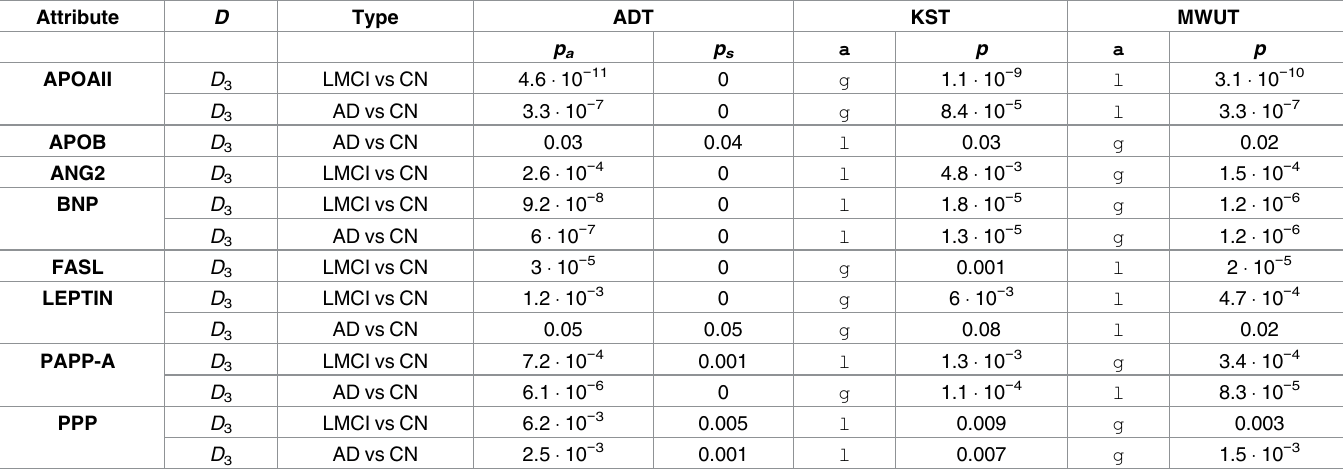
Table 6. Analysed attributes with statistically significant difference in value distribution between groups of LMCI or AD patients and CN subjects. Attribute